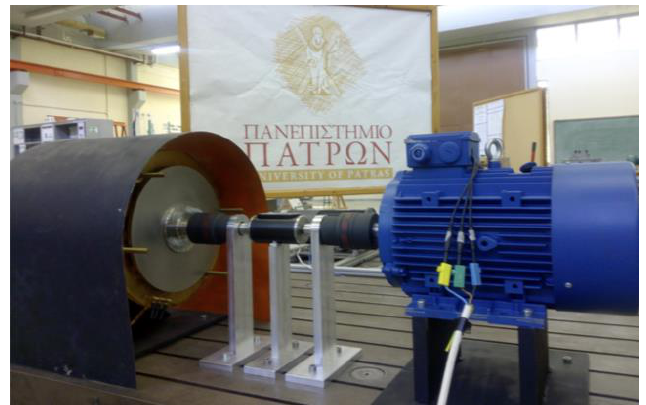
Energies 2017 , 10 , 269